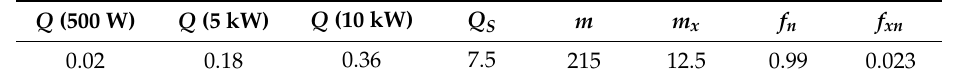
Table 4. Normalized parameters of the prototype.